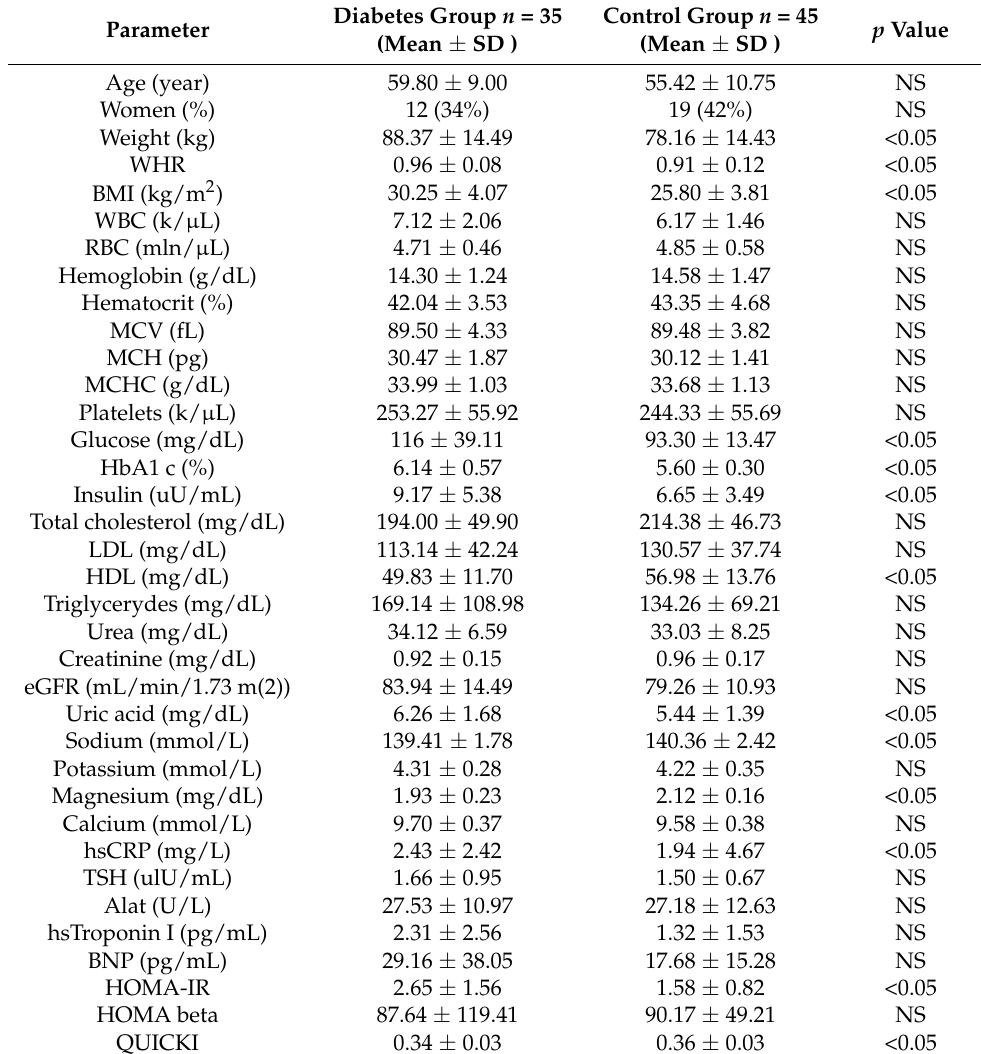
Table 1. Demographic and biochemical characteristics between studied groups including cardiovas- cular risk stratification parameters. Results are presented as mean ±